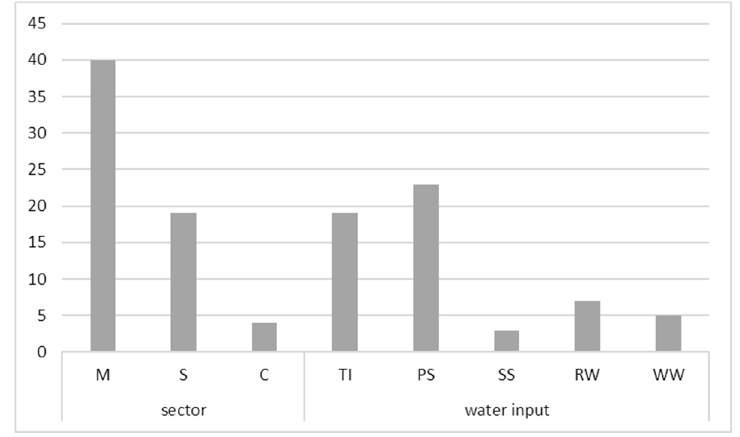
Figure 3. Number of studies by sector and water input. Note: M, manufacturing; S, service; C, construction; TI, total intake; PS, publicly supplied; SS, self-supplied; RW, recirculated water; WW, wastewater.